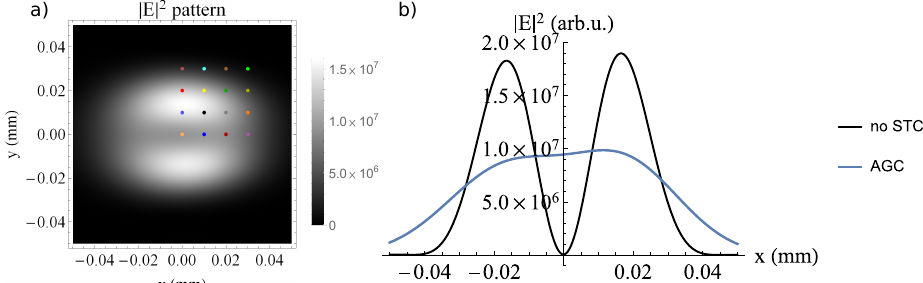
2 ) of the laser field with AGC = 1.28 mrad/PHz in Figure 9. The fluence profile(time-integrated E | | the focal plane, after being reflected by the helical mirror and the focusing mirror of f = 1500 mm ( a ) on x y and ( b ) on x when y = 0 (blue curve). The AGC case is compared with the same laser − field, but without STC (black curve). The colored dots in ( a ) represent the positions at which the time profiles from Figure 10 are